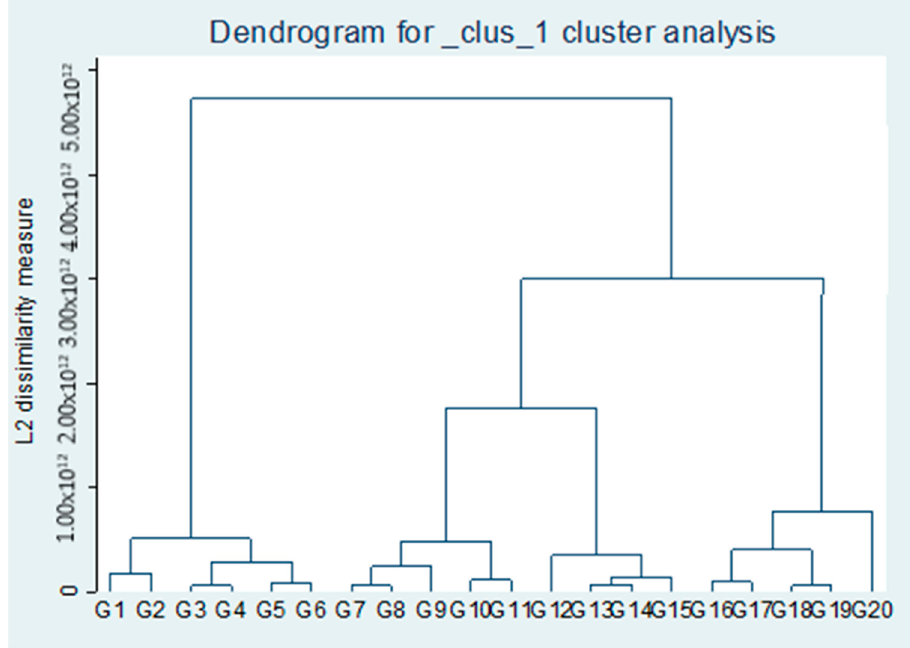
Figure 6. Hierarchical structure tree of the distribution of energy consumption drivers.